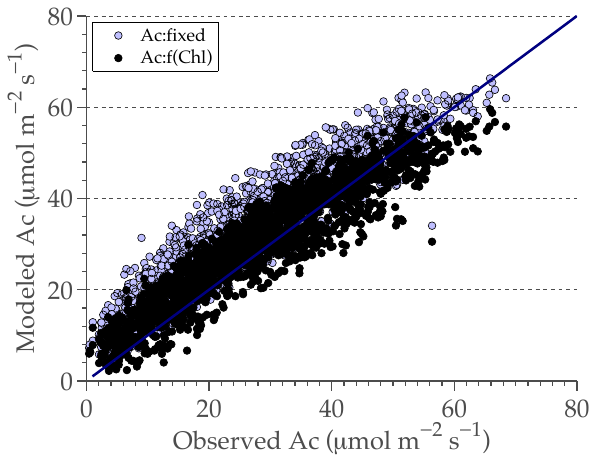
795 Fig. 8. Comparison of hourly modeled and measured energy balance components for maize and 796 Figure 8. Comparison of hourly modeled and measured energy bal- soybean at Mead, NE, generated with TSEB-LUE using fixed values of 𝛽 ! (hollow points) and 797 ance components for maize and soybean at Mead, NE, generated 𝛽 ! as a function of Chl (solid points). 798 with TSEB-LUE using fixed values of β n (light-blue points) and β n as a function of Chl (black points).